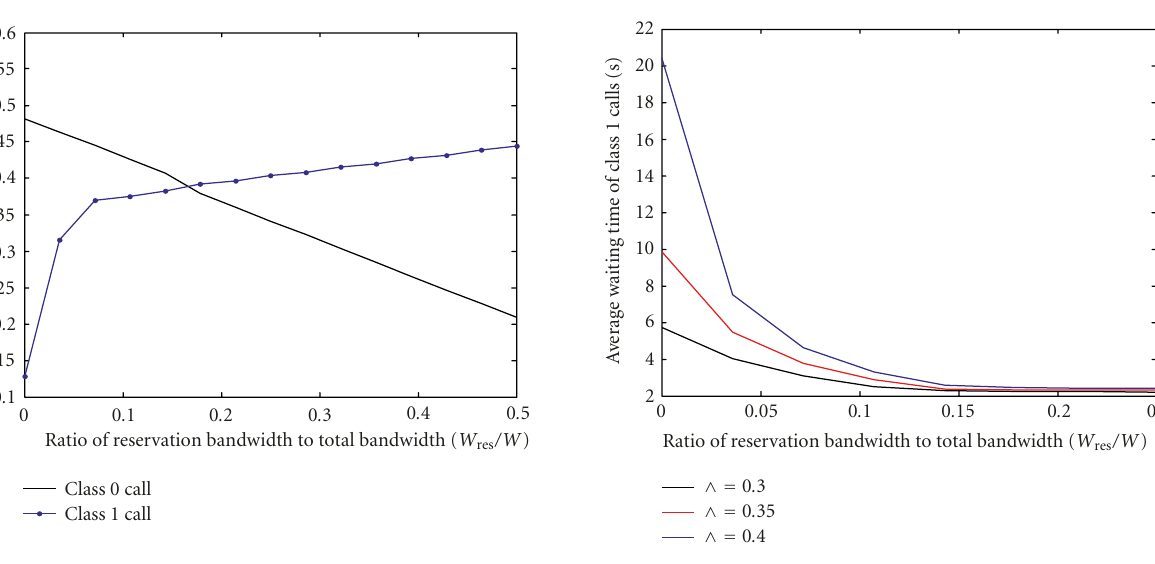
Figure 9: Throughput versus reservation bandwidth ratio, W res /W. Figure 10: Average waiting time of class 1 calls versus reservation bandwidth ratio, W res